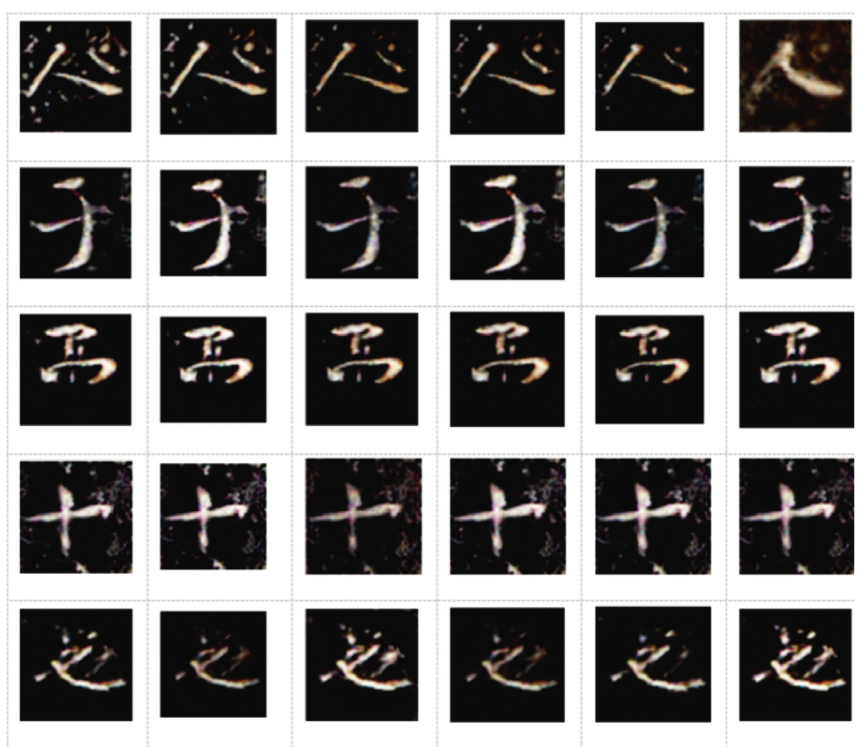
Figure 8: Partial generated